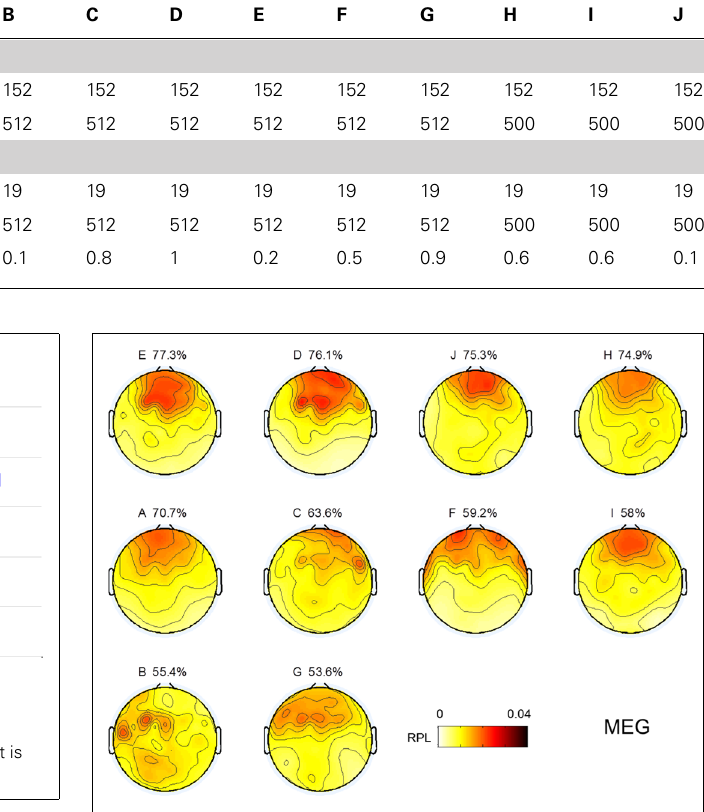
FIGURE 3 |Topographic images for MEG gamma. Images are sorted in descending order of MI performance with